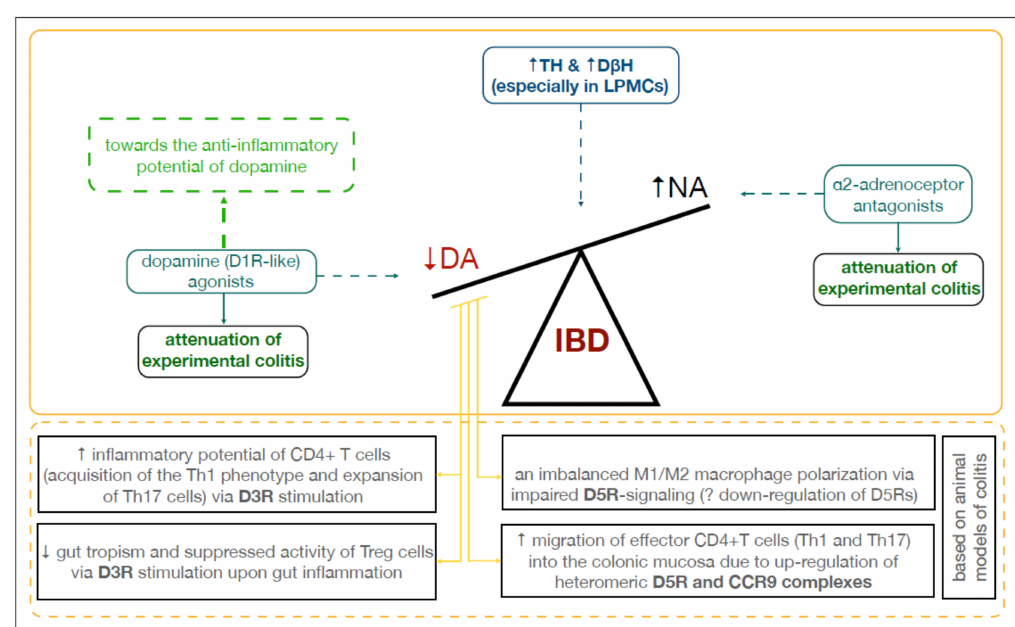
Figure 3. Dopamine in the inflamed colon. Abbreviations: CCR9: C-C chemokine receptor type 9; DA: dopamine; D3R, D5R: dopamine receptors; D β H: dopamine β -hydroxylase; IBD: inflammatory bowel disease; LPMCs: lamina propria mononuclear cells; NA: noradrenaline; TH: tyrosine